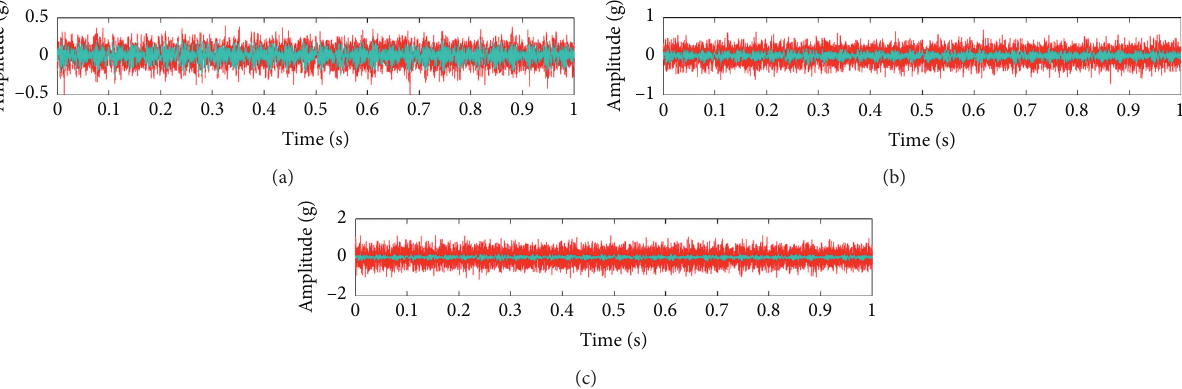
Figure 15: Time-domain comparison of noised signals with different SNRs: (a) 22dB; (b) 16dB; (c) 10dB.